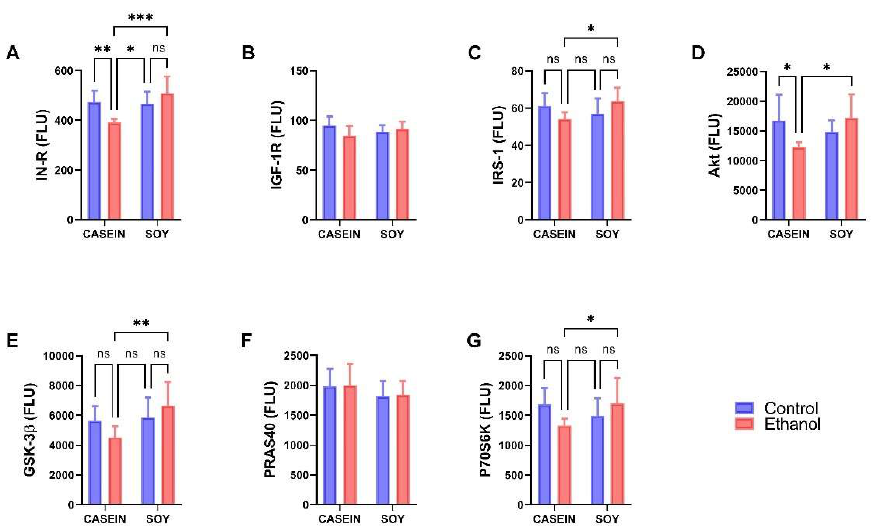
Figure 3. Effects of chronic ethanol and dietary soy isolate on insulin-IRS-1-Akt pathway protein expression in temporal lobe. Long Evans male and female young adolescent rats were fed for 7 weeks with isocaloric liquid diets containing 0% or 37% (3 weeks) followed by 26% (4 weeks) ethanol and casein (standard) or soy isolate as the protein source. Temporal lobe homogenates were used to measure ( A ) IN-R, ( B ) IGF-1R, ( C ) IRS-1, ( D ) Akt, ( E ) GSK-3 β , ( F ) PRAS40 and ( G ) p70S6K with the Total Akt Magnetic 7-Plex Panel. Data from the male and female rats were combined since there were no sex-related differences. Graphed results reflect the mean ± S.D. of immunoreactivity expressed as fluorescence light units (FLU). Results were analyzed using two-way ANOVA tests (Table 3) with post hoc Tukey tests. Significant P-Values are indicated above the bars. * p < 0.05; ** p < 0.01; *** p < 0.001; NS = not